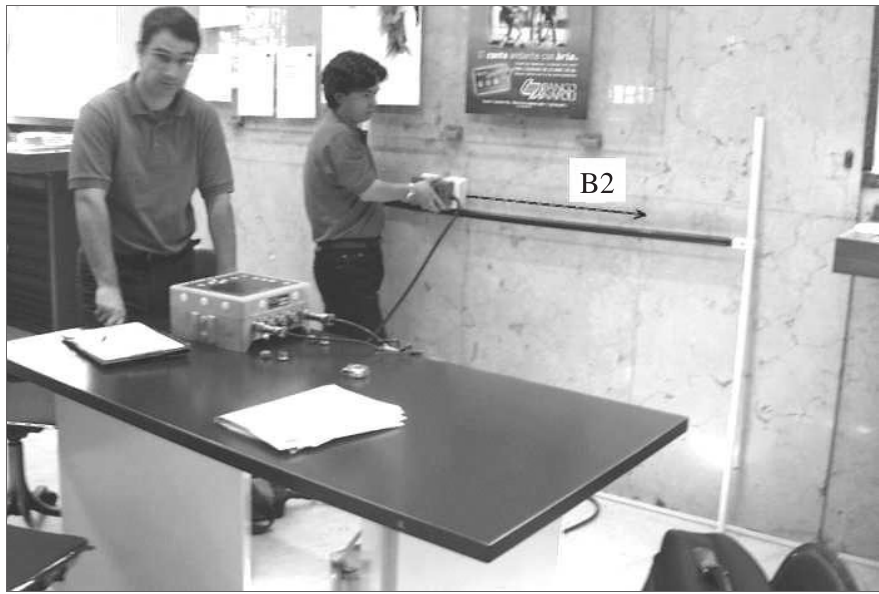
Fig. 6. Photo of the travertine panel inside to the Bank of Naples in Campobasso with the location of B2 radar